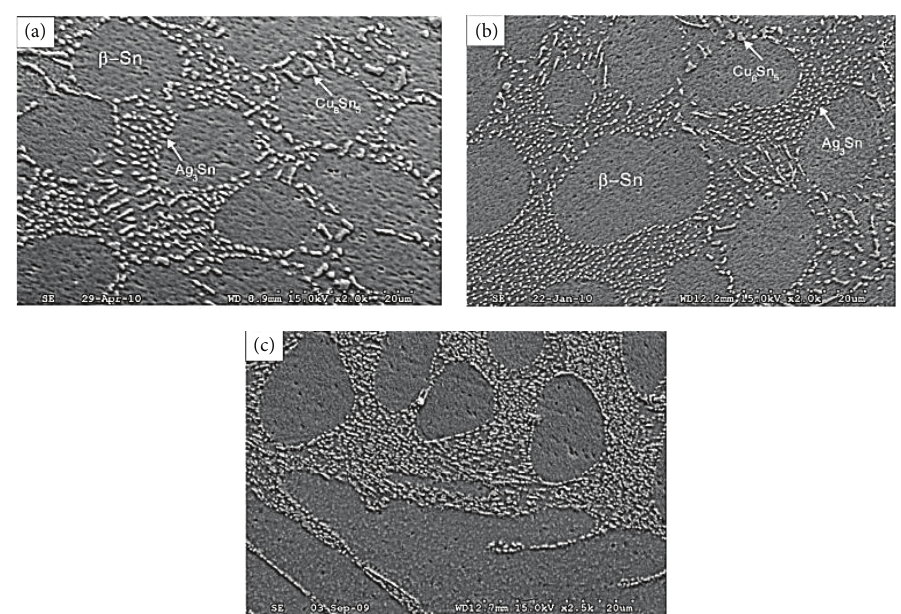
Figure 8: (a) SAC, (b) SAC-0.5Al 2 O 3 , and (c) SAC-1.0Al 2 O 3